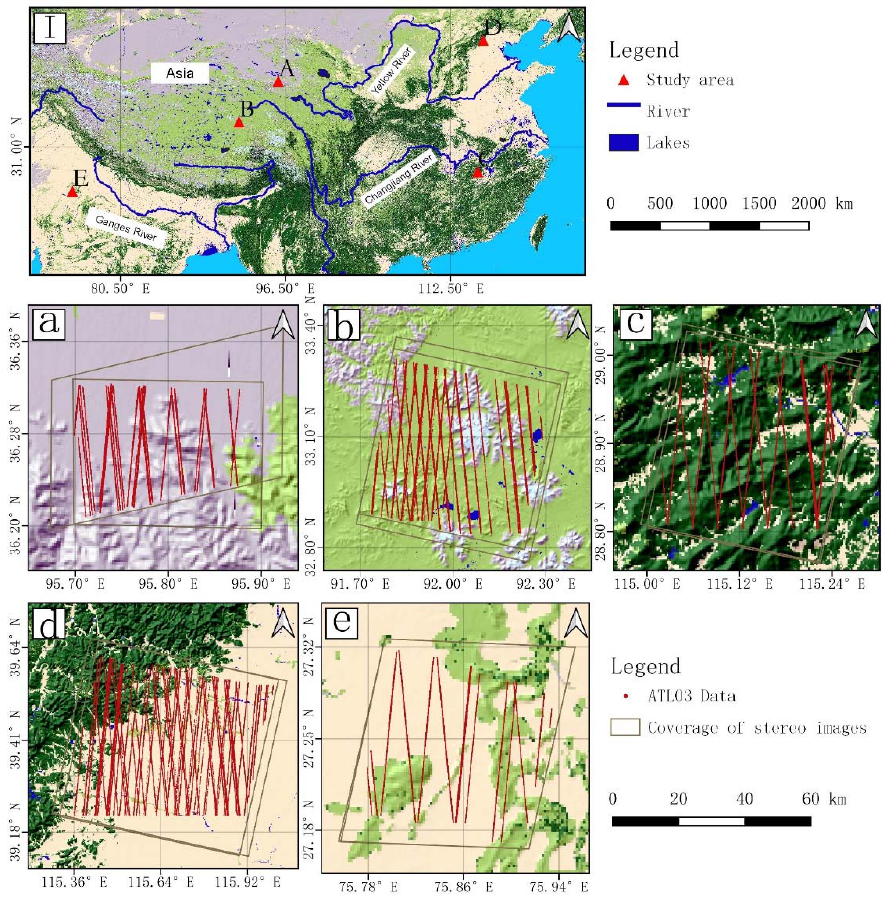
Figure 1. Location of study area and the distribution of satellite laser footprints: ( I ) location of 5 study areas, ( a – e ) is the distribution of ATL03 footprints in study area A to study area E, as described in Table